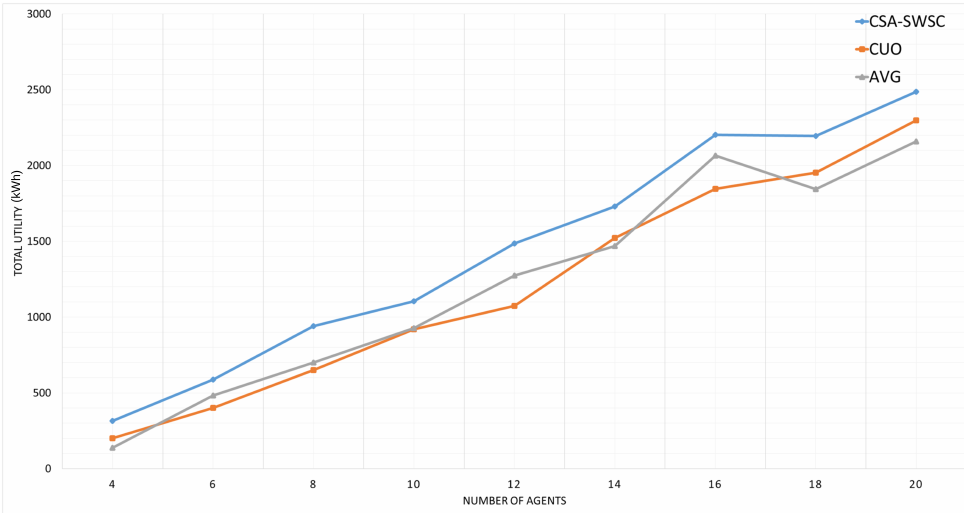
Figure 6. Variation in total utility of sellers with number of agents.